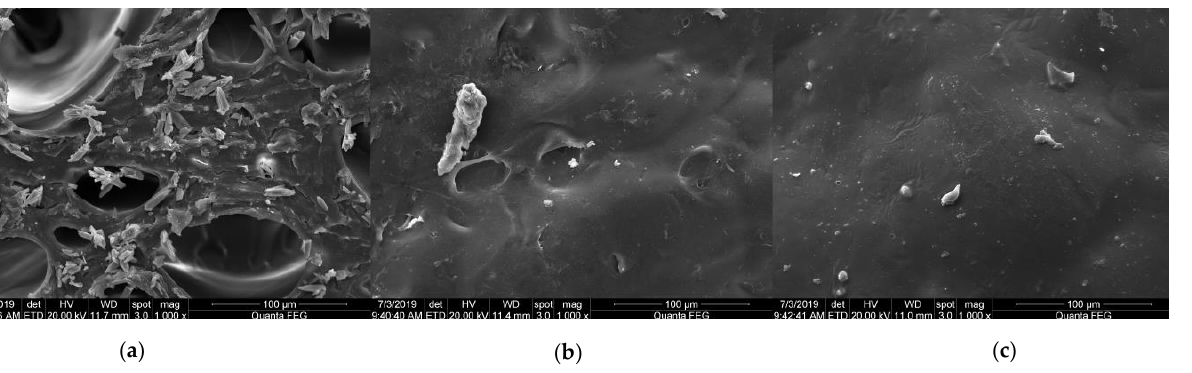
Different superscript letters in the same column indicate significant difference ( p < 0.05).